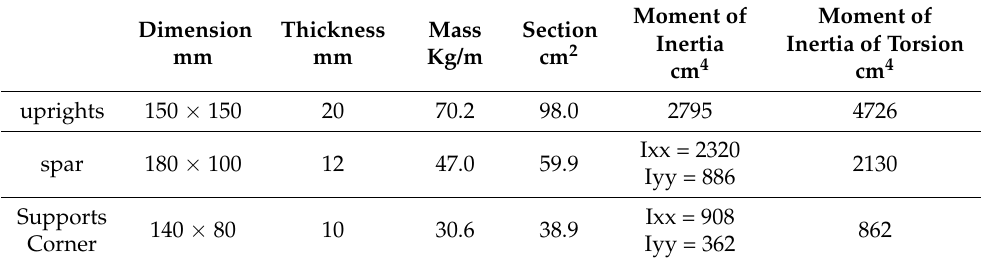
Table 5. Geometric and inertial characteristics.